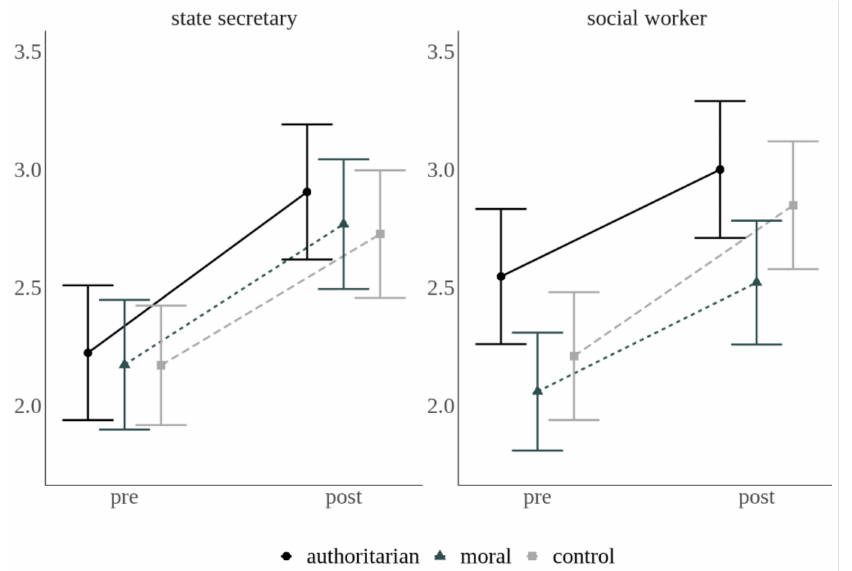
Figure 2. Mean ratings (95% CI) in response to Item 5, asking about wearing a mask in public indoor spaces, before (pre) and after (post) the message